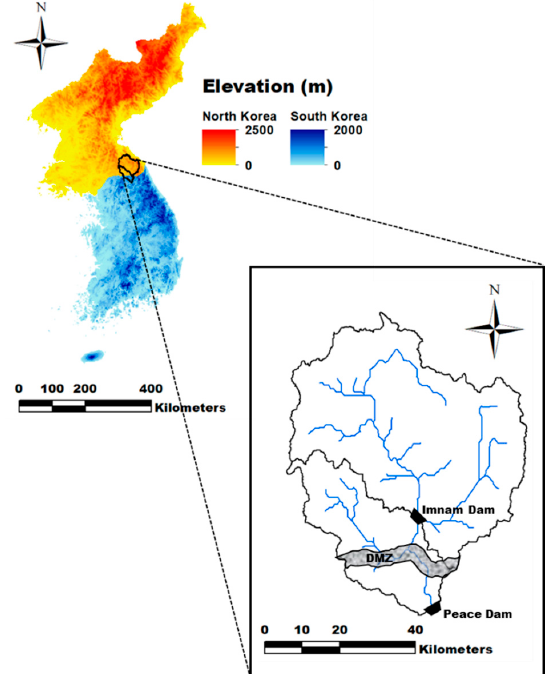
Figure 1. Locations of the Peace Dam in South Korea and the Imnam Dam in North Korea. These two dams are separated by the demilitarized zone (DMZ).